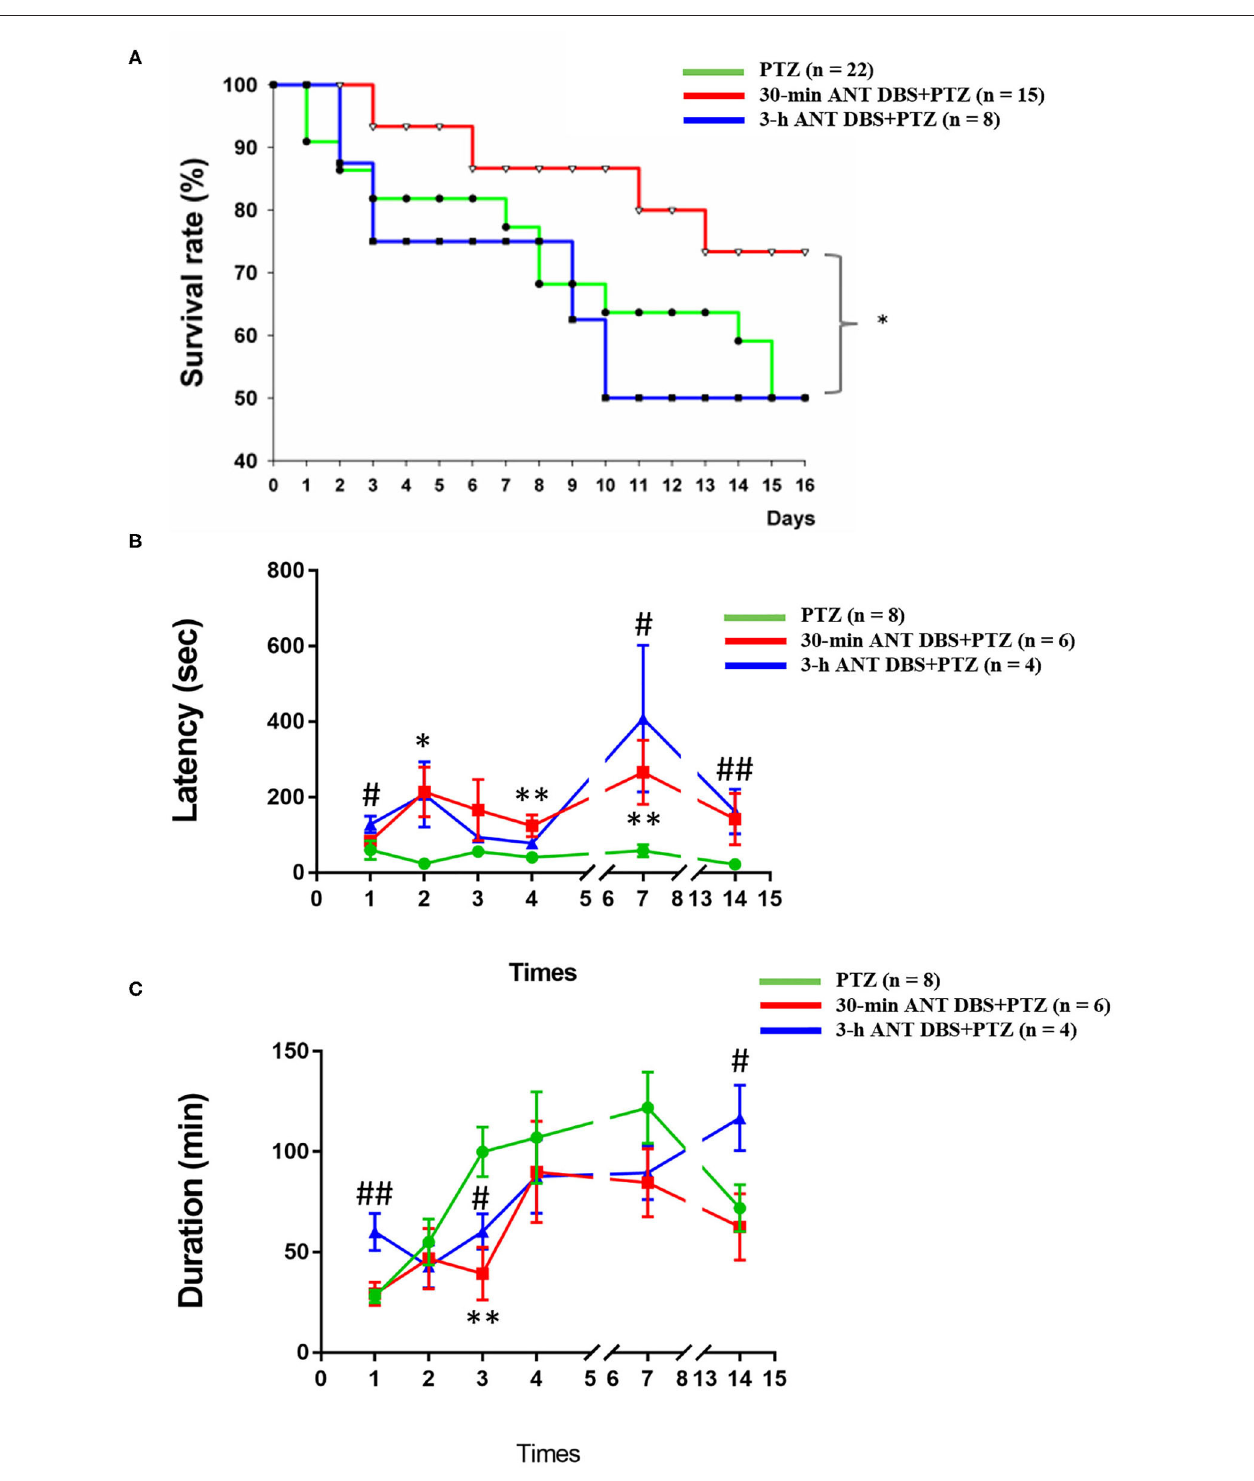
FIGURE 2 | Effects of anterior nucleus of thalamus (ANT) deep brain stimulation (DBS) on the severity of pentylenetetrazol (PTZ)-induced seizure. (A) Effects of 30-min ANT DBS and 3-h ANT DBS on survival rate during the progression of PTZ kindling. * p < 0.05, 30-min ANT DBS + PTZ group vs. PTZ group, chi-square test. (B) ANT DBS prolonged the onset latency of ictal seizure induced by PTZ kindling. (C) ANT DBS reduced the duration of spontaneous seizure duration induced by PTZ kindling. * p < 0.05, ** p < 0.01, 30-min ANT DBS + PTZ group vs. PTZ group, one-way ANOVA; # p < 0.05, ## p < 0.01, 3-h ANT DBS + PTZ group vs. PTZ group, one-way